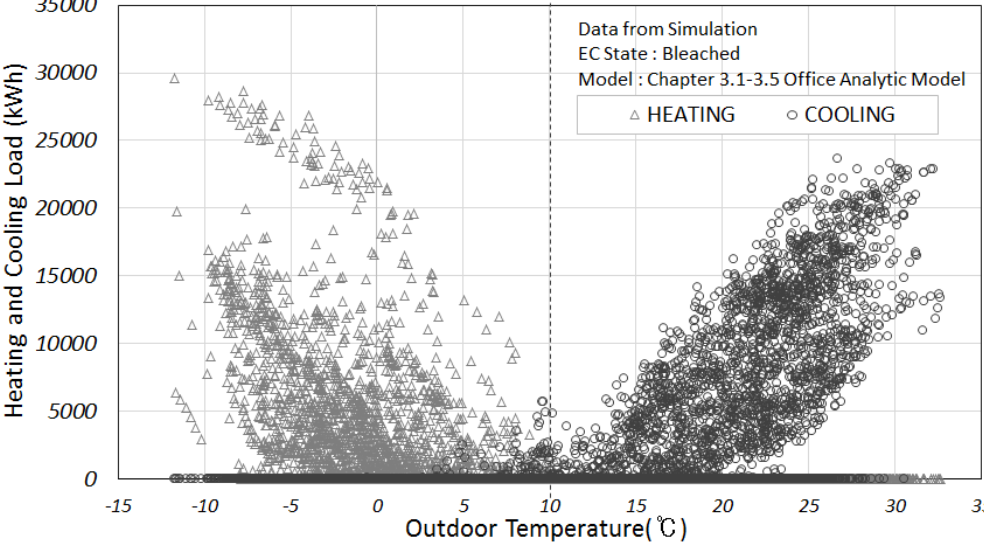
Figure 6. Scatterplot of cooling and heating load by outdoor temperature.